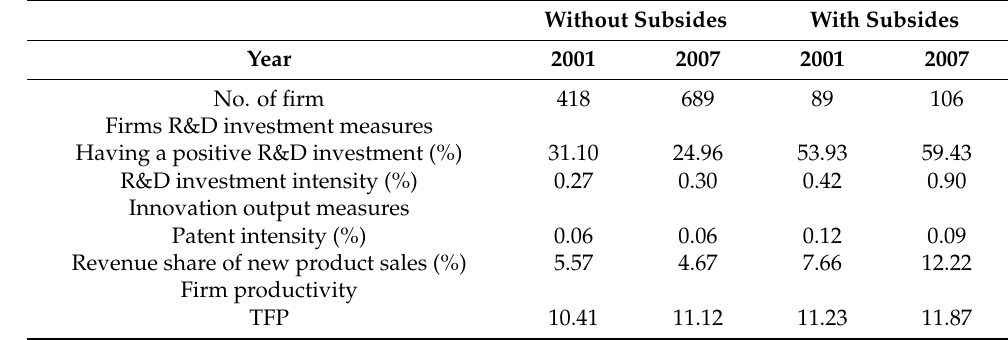
Table 3. Summary statistics of key variables among firms with and without production subsidies in 2001 and 2007.